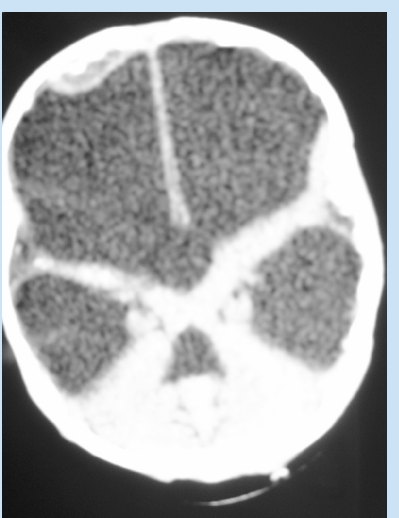
Fig. 3. The long-term follow-up CT in patient 2 demonstrates severe cortical and white matter losses, as well as peripheral cortical linear calcifi- cation in keeping with cortical laminar